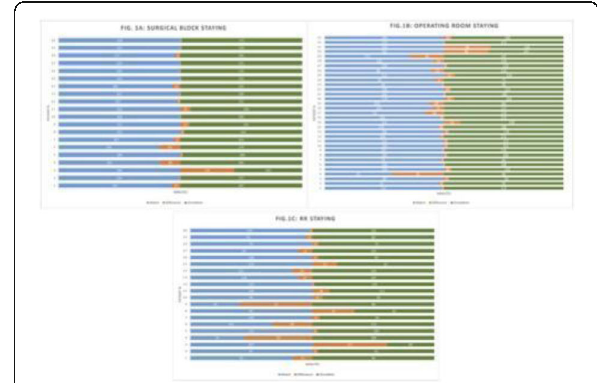
Fig. 1 (abstract A18). A : Surgical block staying. In blue time (min) recorded by the watch (min). In green time (min) recorded on OrmaWeb. In orange the difference (min) between the two records. The mean difference between the two records is 19.3 minutes with a mean % difference of 6.9%. B : Operating room staying. In blue time (min) recorded by the watch (min). In green time (min) recorded on OrmaWeb. In orange the difference (min) between the two records. The mean difference between the two records is 17.1 minutes with a mean % difference of 11.1%. C : Recovery room staying. In blue time (min) recorded by the watch (min). In green time (min) recorded on OrmaWeb. In orange the difference (min) between the two records. The mean difference between the two records is 24.5 minutes with a mean % difference of 27.8%